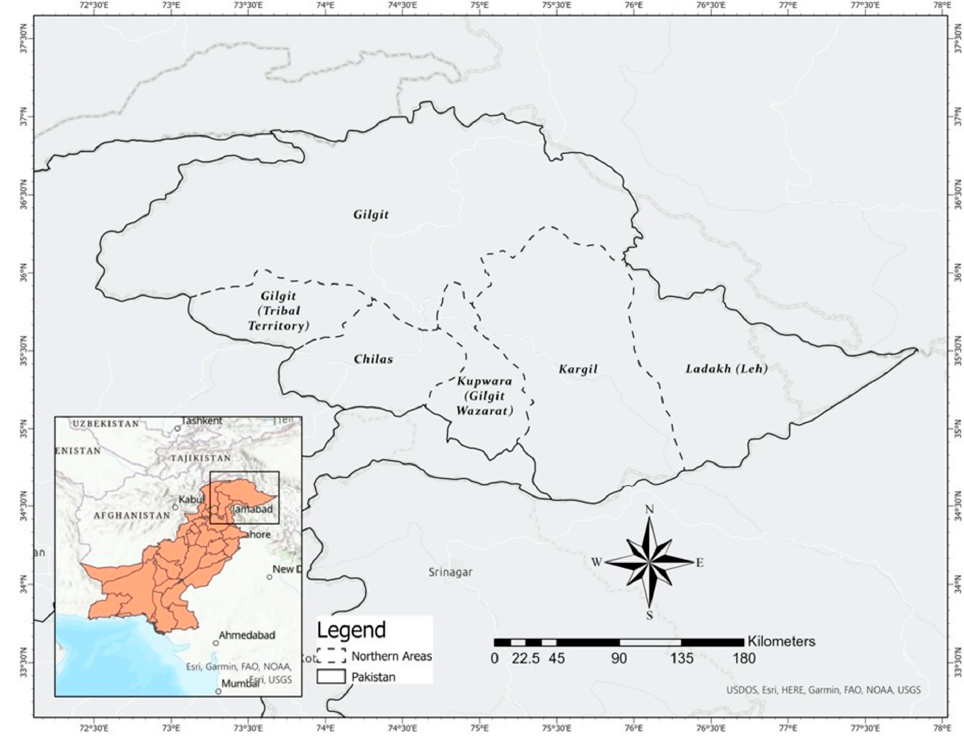
Figure 3. Northern